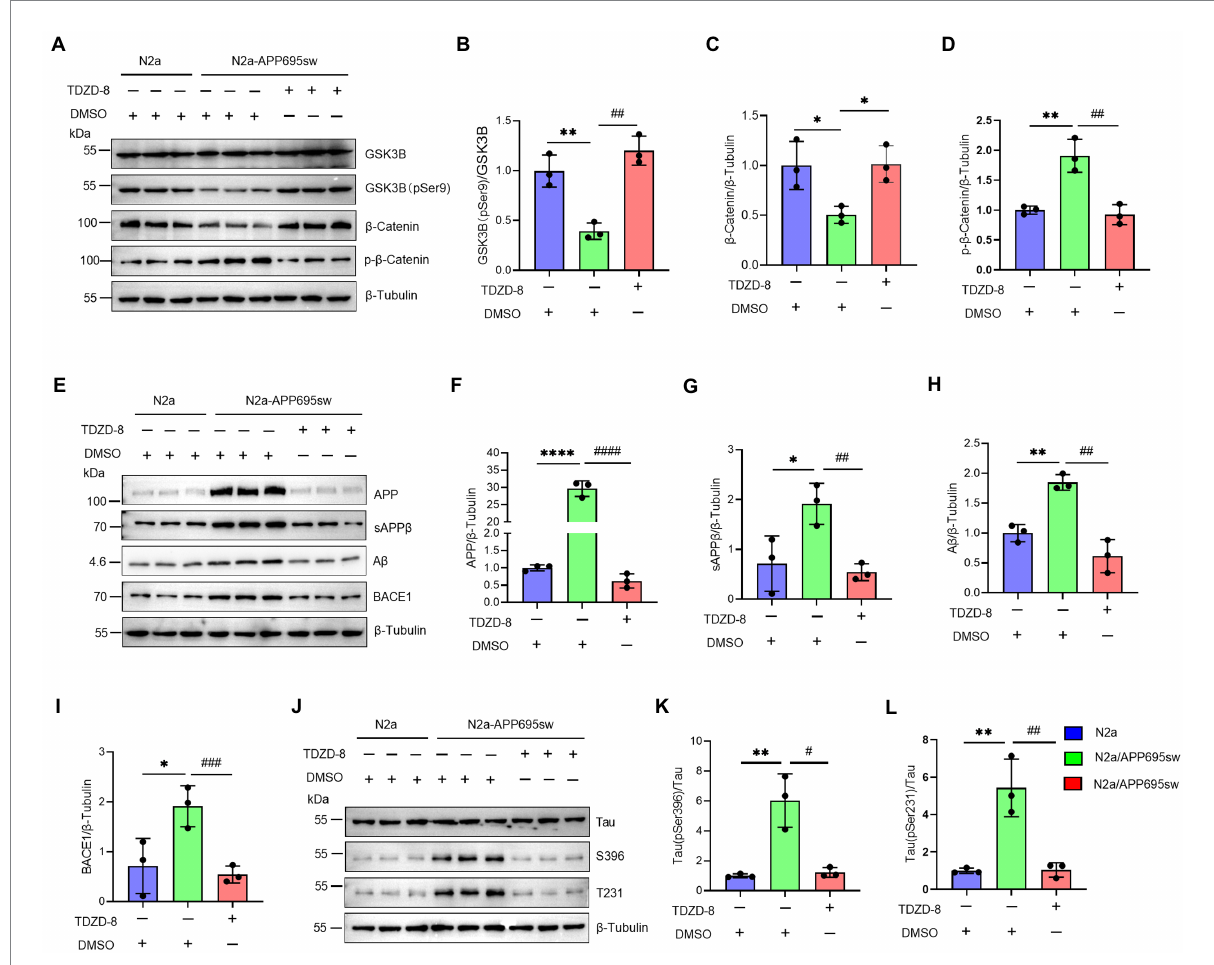
FIGURE 5 GSK3B inhibitor TDZD-8 promoted APP metabolism and repressed GFAP generation and Tau phosphorylation in N2a-APP695sw cells. (A–L) , N2a and N2a-APP695sw cells were treated with DMSO or TDZD-8 (25 μ M) for 48 h. The GSK3B, phosphorylated GSK3B at serine 9 [GSK3B (pSer9)], β -Catenin, and phosphorylated β -Catenin were measured using Western blotting (A) , and then quantified (B–D) . The APP metabolism-related protein levels were measured using Western blotting (E) , and then quantified (F–I) . The Tau and phosphorylated Tau protein levels were measured using Western blotting (J) , and then quantified (K,L) . Data are presented as mean ± SD, n = 3. ∗ p < 0.05; ∗∗ p < 0.01; ∗∗∗∗ p < 0.0001 for N2a-APP695sw (DMSO) versus N2a (DMSO). # p < 0.05; ## p < 0.01; ### p < 0.001; #### p < 0.0001 for N2a-APP695sw (TDZD-8, 25 μ M) versus N2a-APP695sw (DMSO). The student’s t -test was